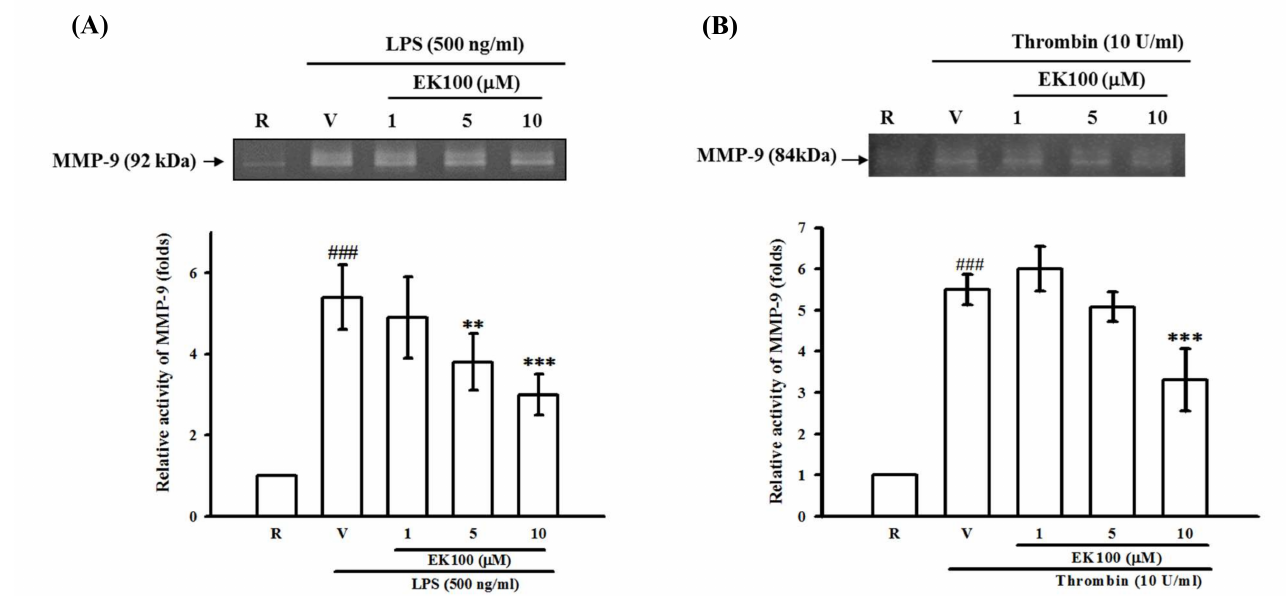
Figure 5. Effects of EK100 on LPS- and thrombin-induced MMP-9 activation in astrocytes. Rat primary astrocytes were pretreated with the vehicle (V) or EK100 (1, 5, and 10 µ M), and stimulated with either ( A ) LPS (500 ng/mL) or ( B ) thrombin (10 U/mL) for 24 h as indicated. Cell-free supernatants were then assayed for MMP-9 activity by gelatin zymography. The relative multiples of densitometric data are shown as the mean ± SD ( n = 3 and 4). ### p < 0.001 compared with the resting group (R); * p < 0.05, ** p < 0.01 compared with the vehicle under